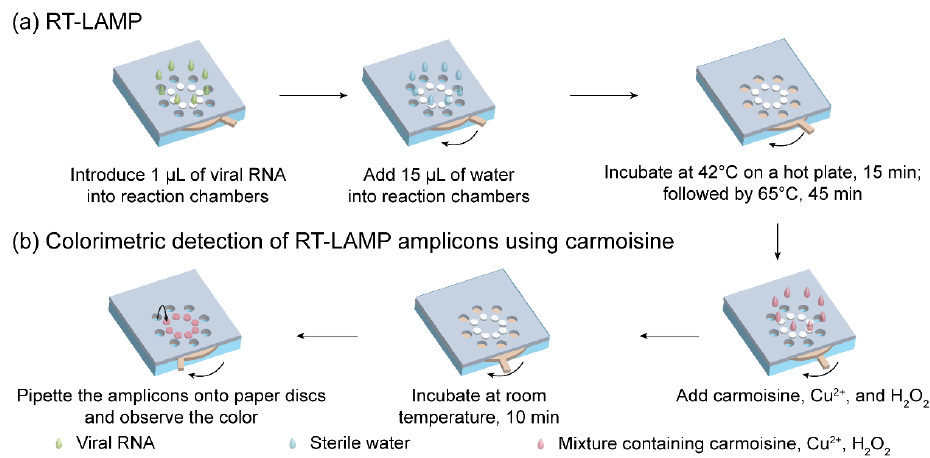
Figure 3. Operation of the rotatable paper device. Procedure for ( a ) RT-LAMP reaction and ( b ) colorimetric detection using carmoisine.